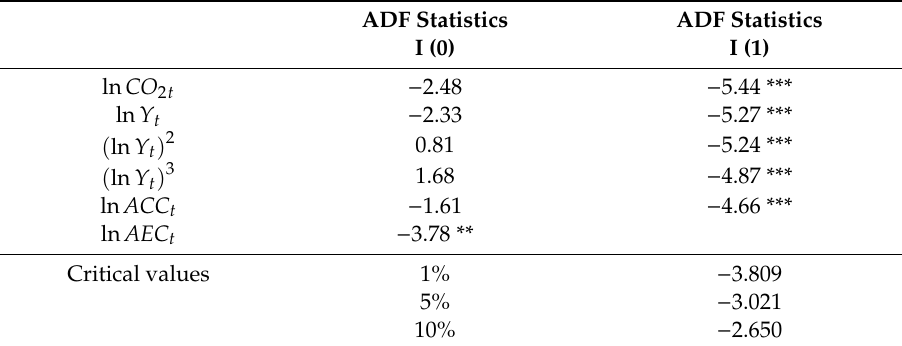
Table 4. Augmented Dickey-Fuller unit root test.